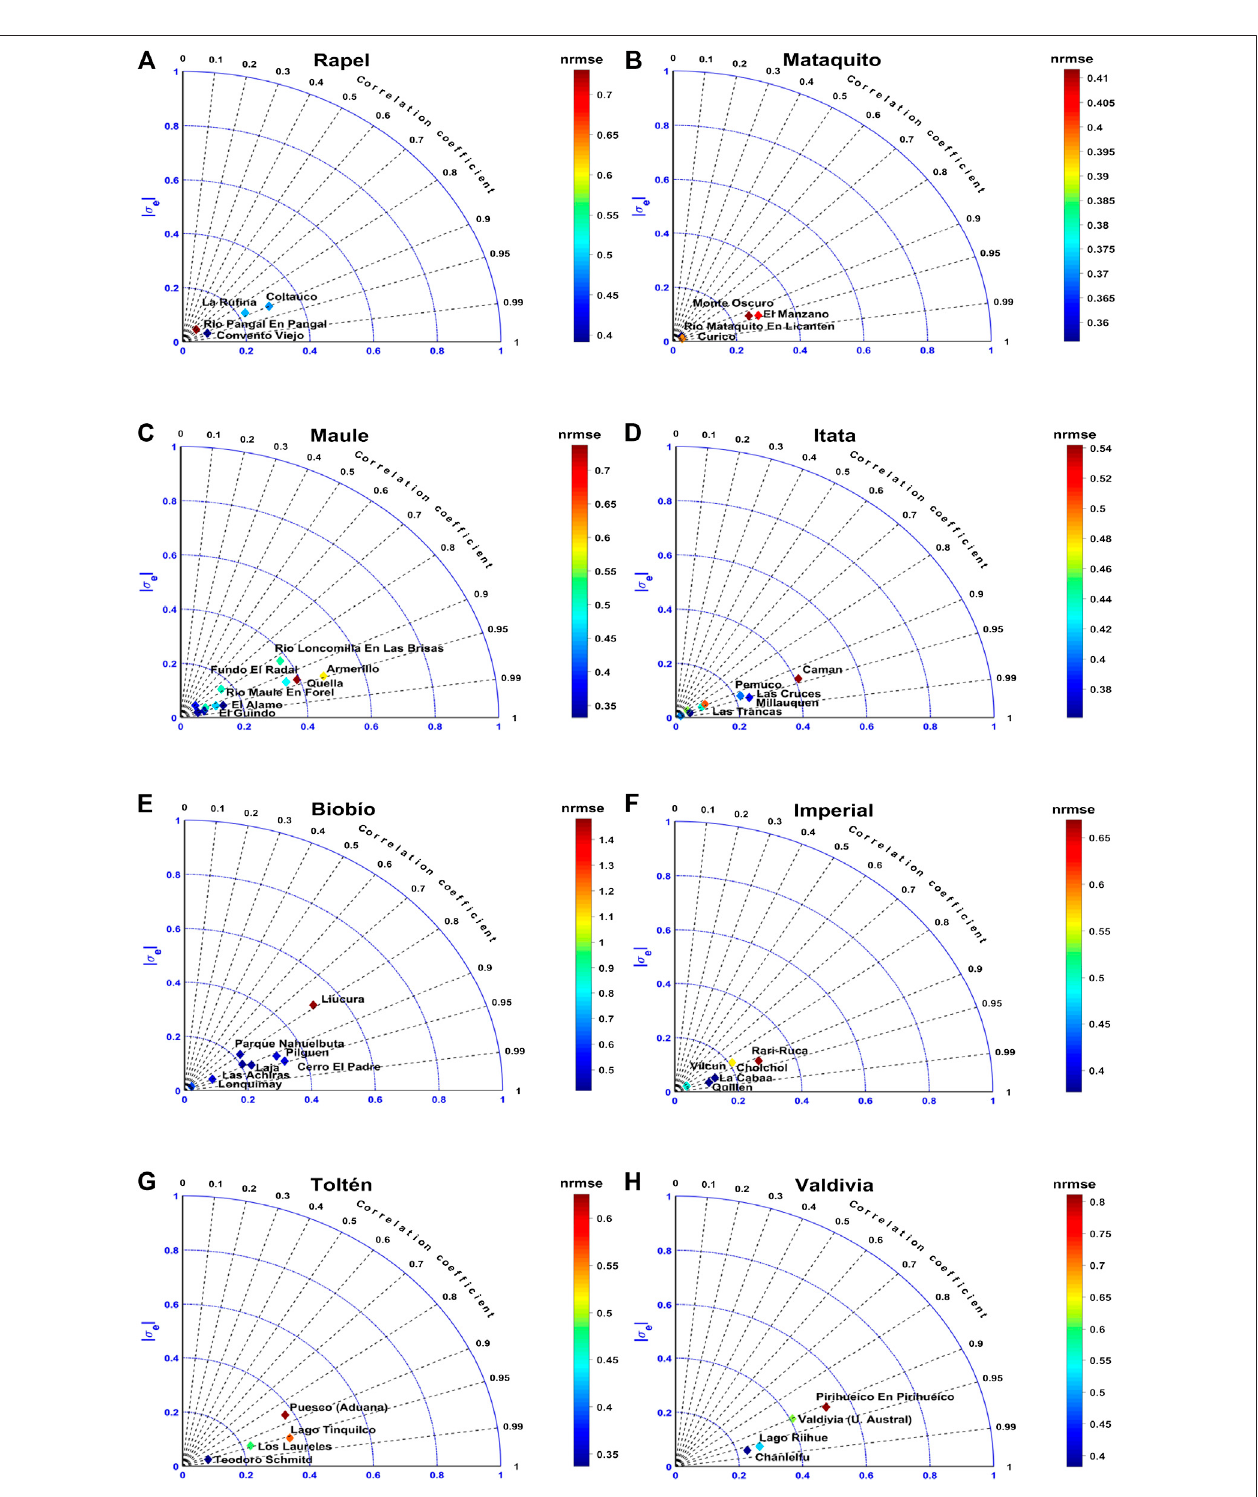
FIGURE11| Taylordiagramscorrespondingtotheperformanceofthetopo-climaticmodelontheriverbasins( Figure1B ): (A) Rapel, (B) Mataquito, (C) Maule, (D) Itata, (E) Biobío, (F) Imperial, (G) Toltén, and (H) Valdivia.